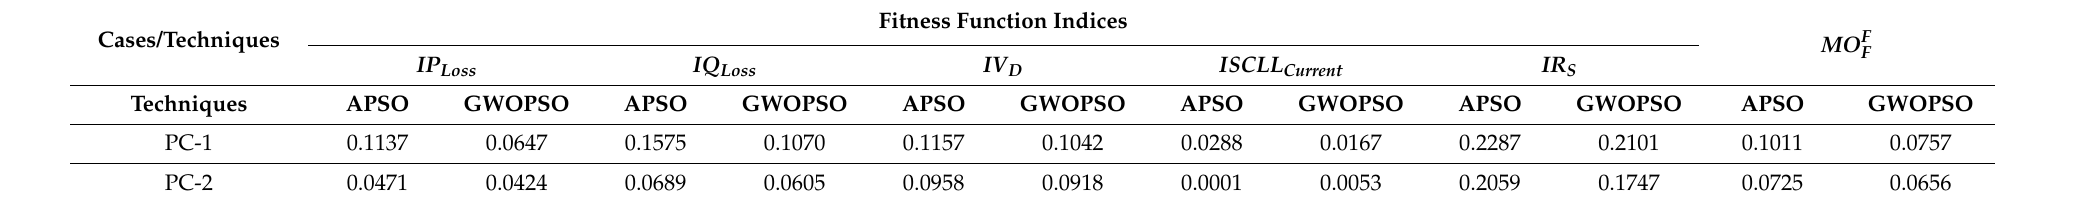
Table 10. The MO F and its indices for IEEE 69-bus RDN. F